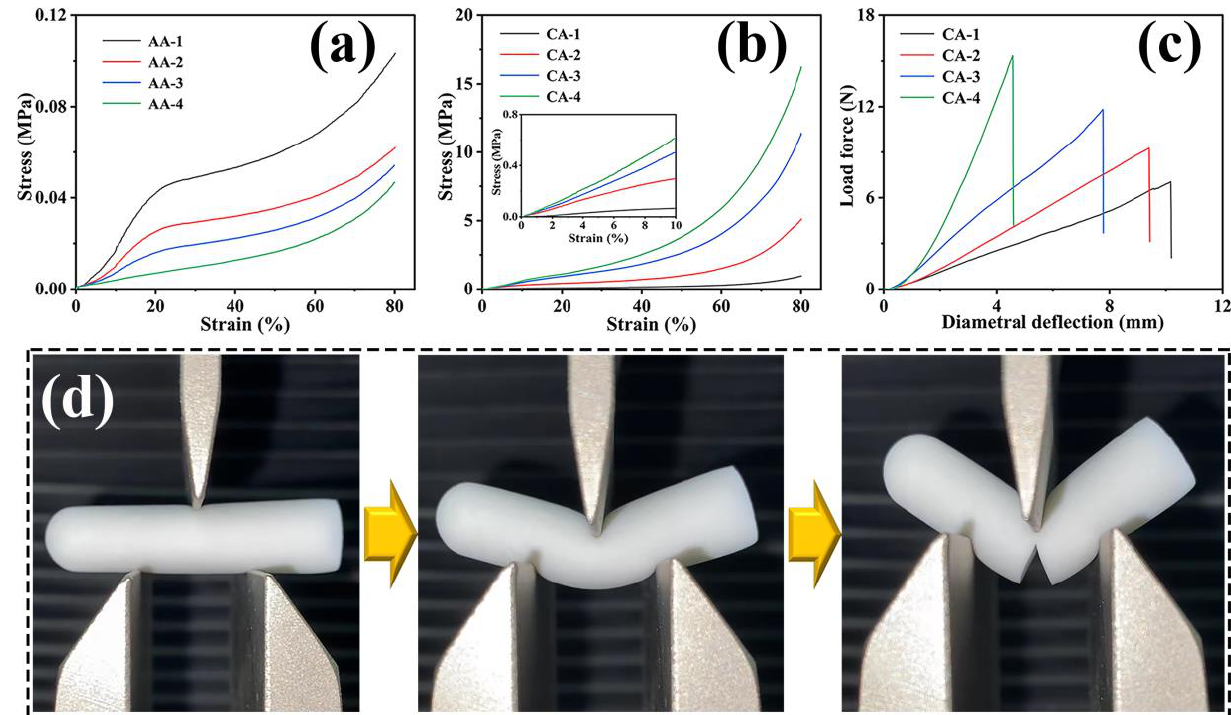
Figure 5. Compressive stress–strain curves of ( a ) AAs and ( b ) CAs (inset of magnification of the part within 10% strain). ( c ) Force–diametral deflection curves of the three-point bending tests on CAs. ( d ) Photographs of a three-point bending test for CA-1.